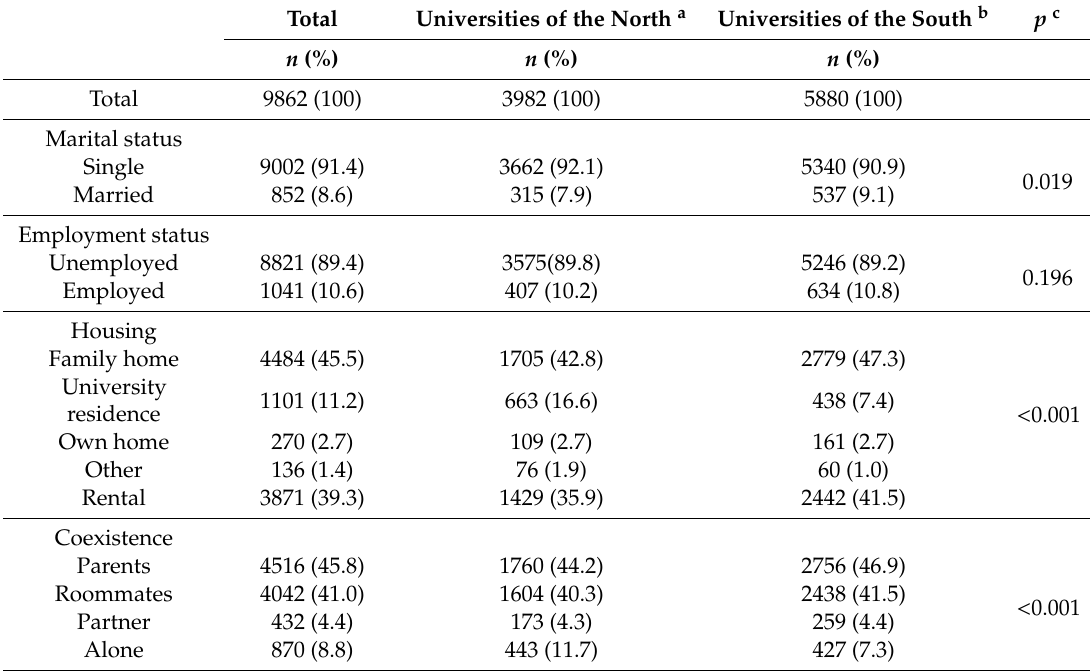
Table 1. Sociodemographic characteristics of the university sample according to the geographical location of the